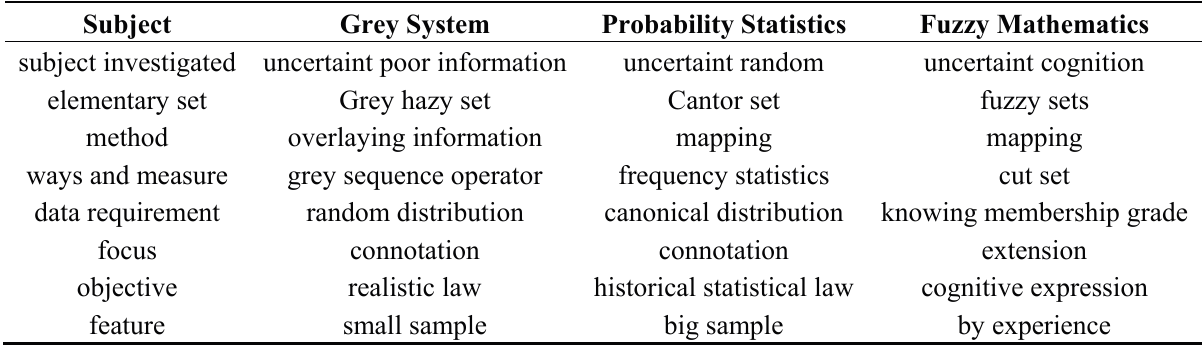
Table 1. Comparison of the three kinds of uncertainty research